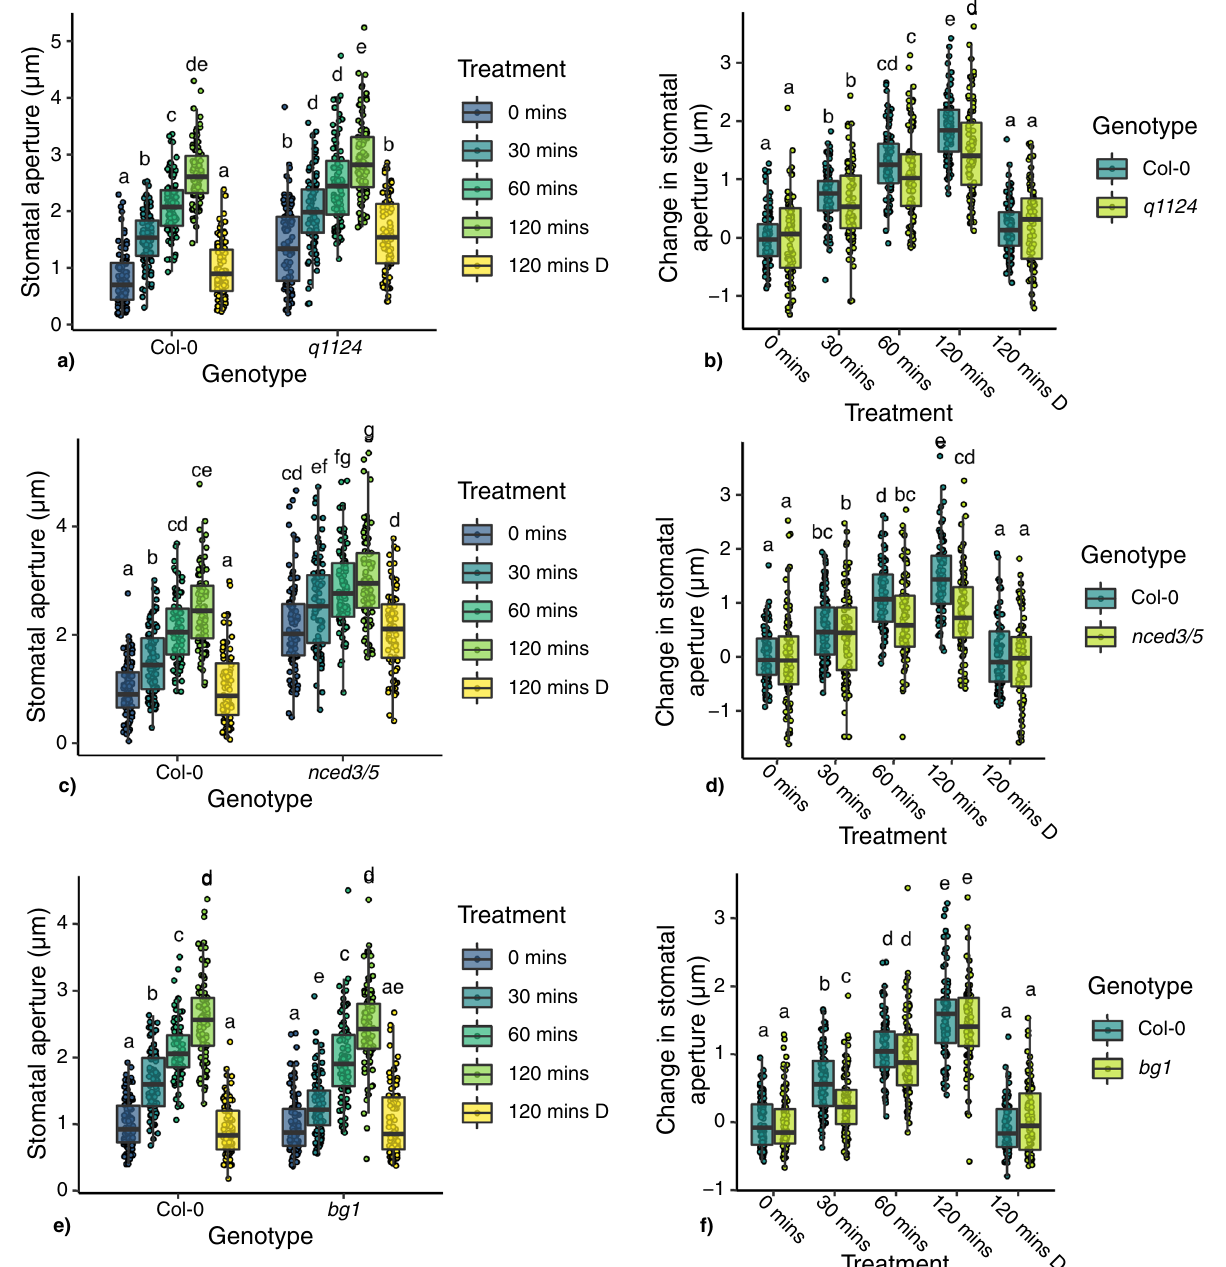
Figure 7. Stomatal responses of ABA biosynthesis and signalling mutants to light. ( a , c , e ) show absolute stomatal apertures and ( b , d , f ) show absolute change in stomatal aperture for q1124 , nced3/5 , and bg1 respectively. Leaf discs were harvested under green light before dawn and incubated in darkness for 2 h before treatment. Treatment times refer to time in light (other than 120 mins D—which refers to 120 mins in darkness). Data is presented in boxplots showing the median and interquartile range of each group. The upper and lower whiskers represent data within 1.5 × the interquartile range. All data values are represented by points. Data was analysed using a 2-way ANOVA with Tukey HSD multiple comparison test, letters denote significant differences at p <